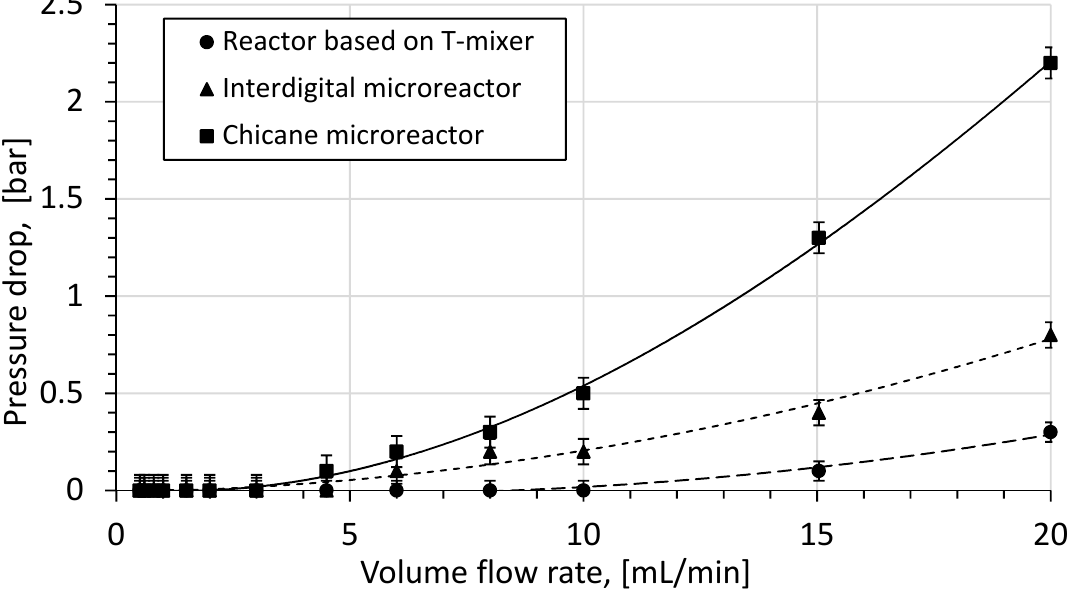
Figure 12. Pressure drop over volume flow rate. Table 6. Determined parameters in the pressure drop model (12) for different reaction systems. Setup Based